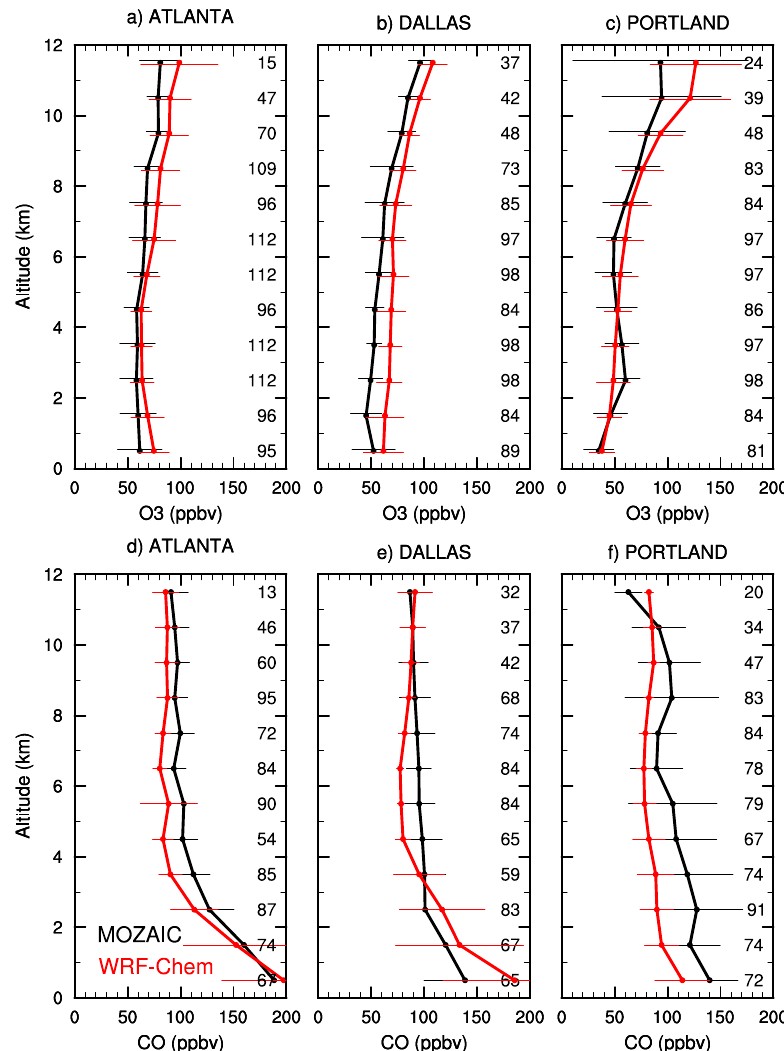
Fig. 9. Average vertical profiles of O 3 (a–c) and CO (d–f) mixing ratios from the MOZAIC data (black lines) and the WRF-Chem simulation (red lines) binned into altitude levels. The profiles are averages over the 15 July to 3 August 2006 when MOZAIC profiles were available. The horizontal lines indicate the standard deviation for each of the datasets and the numbers on the right side of the plots are the number of samples for each altitude